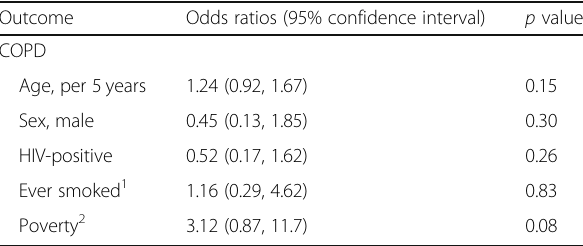
Table 3 Multivariate logistic regression parameter estimates